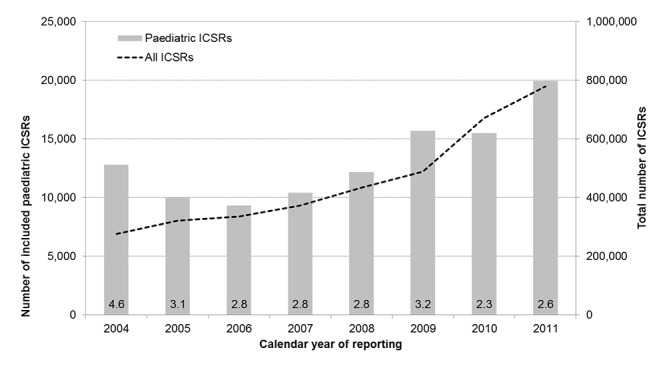
Number of reported ICSRs over time.The number of included pediatric ICSRs is plotted on the left y-axis. The total number of ICSRs within the database is plotted on the right y-axis. Within the bars the proportion of pediatric ICSRs of the total reported ICSRs is given.